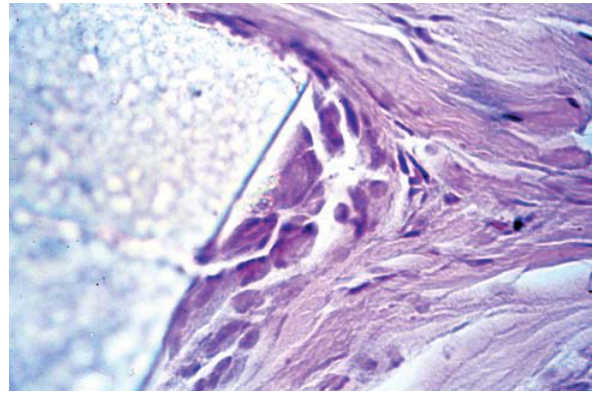
FIGURE 5- 60 days – RC group. Polymer particle surrounded by clastic cells (H.E., original magnification, x400)